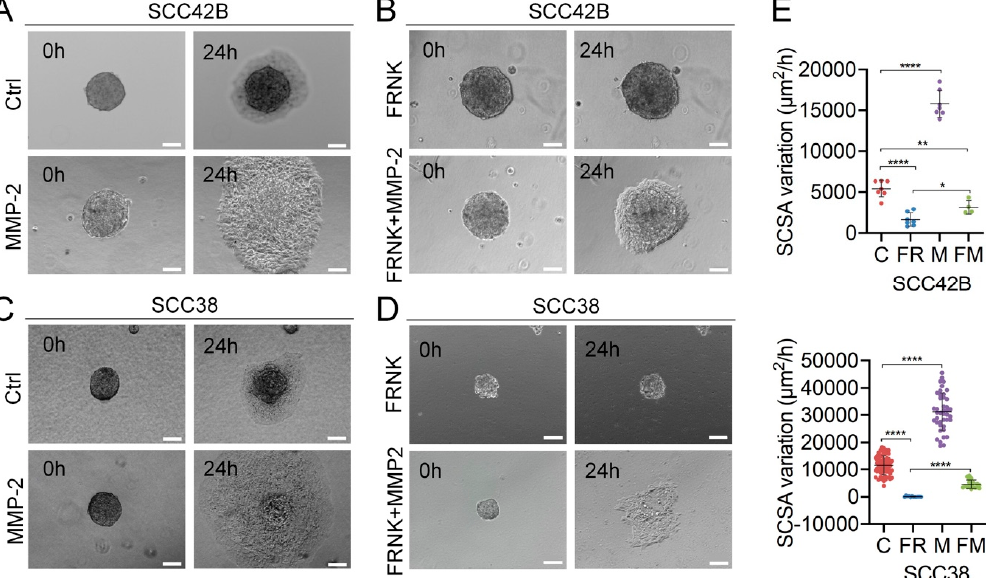
Figure 4. MMP-2 promotes collective cell invasion of FAK-deficient and proficient SCC cells. ( A – D ) Spheroids were assembled with the indicated SCC cells infected with empty vector (Ctrl) or overexpressing FRNK, MMP-2 or FRNK + MMP-2 and incubated for 0 or 24 h. ( E ) Variations over time of the SCSA of control (C), FRNK (FR), MMP-2 (M) or FRNK + MMP-2 (FM) spheroids. Data are presented as mean ± standard deviation from 3–5 individual experiments. Scale bars, 100 µm. * indicates p < 0.01, ** indicates p < 0.001, **** indicates p < 0.0001. As SCC tumors have a high degree of cellular heterogeneity, we tested whether, similarly to CAFs, the presence of M-SCC or C-SCC cells in FR-SCC multicellular spheroids could release FR- SCC cells from their restrained migratory capacity. To this end, mixed spheroids of CMFDA-labelled- M-SCC (or C-SCC), plus FR-SCC, cells were assembled and allowed to migrate for 20 h. As shown in Figure 5, both M-SCC and C-SCC cells allowed collective cell migration of the otherwise immobile FR-SCC cells, an inductive effect that was significantly higher with M- than C-SCC38 cells, as expected (Figure 5). Significantly, fluorescence microscopy images revealed that the CMFDA-labelled cells (C or M cells) moved towards the front of the spheroids but did not detach from FR-SCC38 cells, thus suggesting that FAK-proficient cells pulled FR-SCC38 cells which were mostly localized in the rearguard of the spheroid. Although this phenotype was detected with the two cell lines, SCC38 and SCC42B, differences were observed regarding the distribution of M- or C-SCC cells within the spheroids. Microscopy analysis of mixed SCC42B spheroids revealed that the leading edge was formed by CMFDA-labelled M- or C-SCC42B-multicellular blunted edges but not a long finger-like protrusion with a unique leader invasive cell. This suggests that most CMFDA-labelled M-SCC42B cells emerged from the migrating collective and took the front positions of the invasive spheroid to serve as leaders (Figure 5A). In contrast, fingerlike cell tracks were formed in C- or M + FR-SCC38 spheroids which were led by 1 or 2 CMFDA-labelled M- or C-SCC38 cells. This suggests that only a reduced subset of M- or C-SCC38 cells is able to take the front positions and push the FR-SCC38 immobile cells thus mimicking CAFs’ behavior observed in the FR-SCC38 + CAF3 spheroids. Collectively, the data show that FAK-proficient cells (C-SCC and M-SCC) are able to push FAK- deficient immobile cells but with different strategies depending on the peculiarities of the cellular background and/or the cell-to-cell interactions.